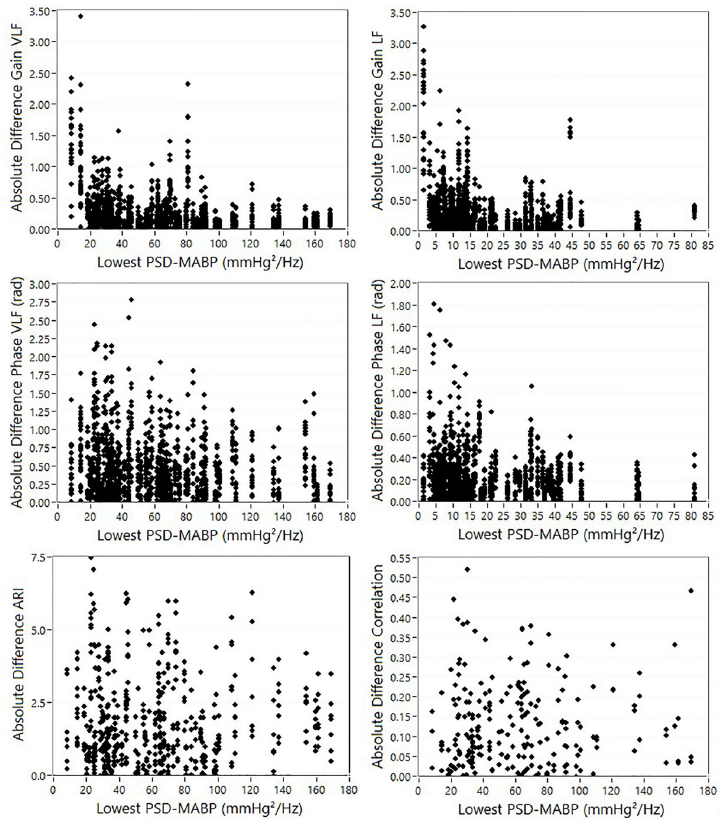
Fig 2. Absolute between measurement differences vs the lowest PSD-MABP of repeated